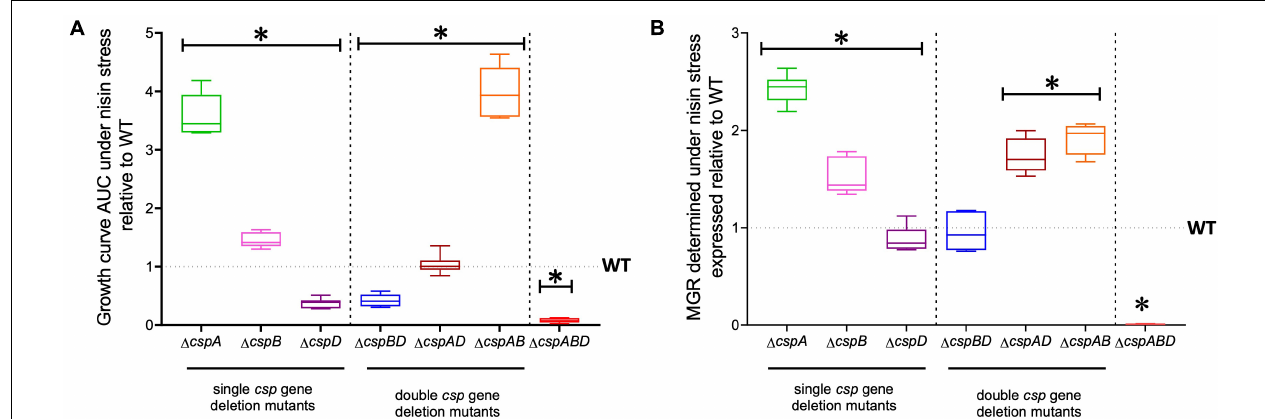
FIGURE 3 | Nisin stress growth efficiency comparison between the wild type (WT) and the single ( (cid:49) cspA , (cid:49) cspB , and (cid:49) cspD ), double ( (cid:49) cspBD , (cid:49) cspAD , and (cid:49) cspAB ), and triple ( (cid:49) cspABD ) csp deletion mutants of L. monocytogenes EGDe. The growth parameters area under the curve (A) and maximum growth rate (B) under nisin stress normalized to growth in nisin-free BHI were determined for the csp mutants and expressed relative to the WT strain levels (WT strain levels equivalent to 1.0 are denoted by a broken line on the graph). The results presented are based on three independent experiments that were performed in duplicates. ∗ P < 0.05, significant differences compared to the WT detected using Tukey’s post-hoc test pairwise comparison following one-way